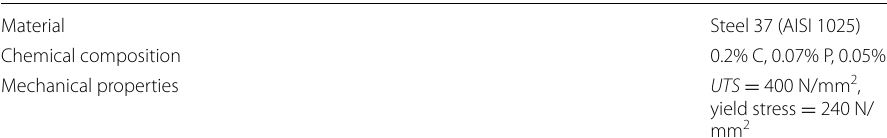
Table 2 Workpiece material properties